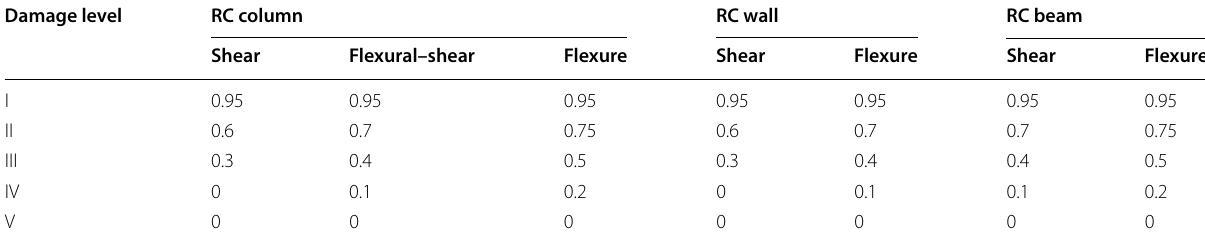
Table 2 Seismic reduction factors suggested by the references (JBDPA 2001, 2015). Damage level